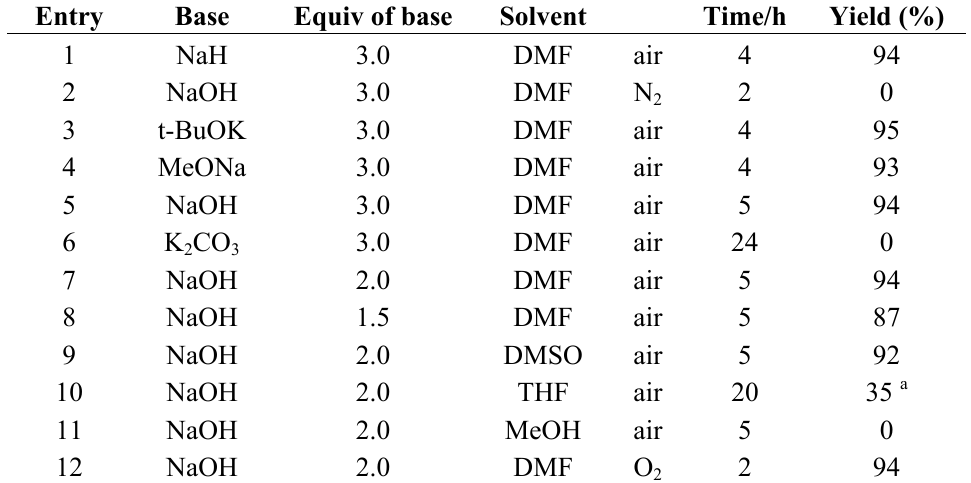
Table 1. Optimization of the Winterfeldt oxidation of 2-Boc-1,2,3,4-tetrahydro- γ -carboline.